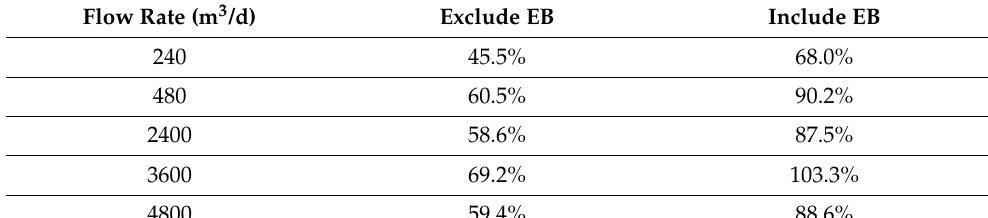
Table 5. Internal rates of return for water reclamation projects for the irrigation of plants and green areas when including and excluding environmental benefits (EB) .